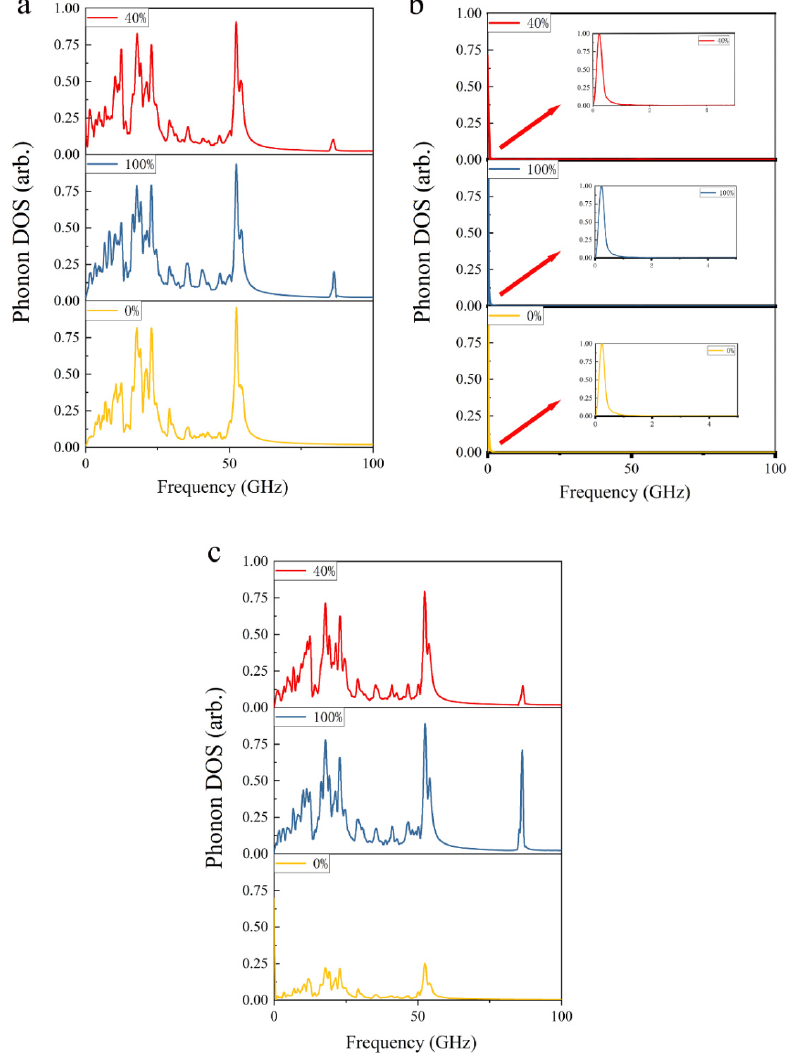
Figure 4. The phonon DOS of the transmission system in three stages when pristine carbon nano- tubes, carbon nanotubes grafted with 40% and 100% hydroxyl groups are applied, respectively: ( a ) relaxation, ( b ) acceleration, and ( c ) deceleration.